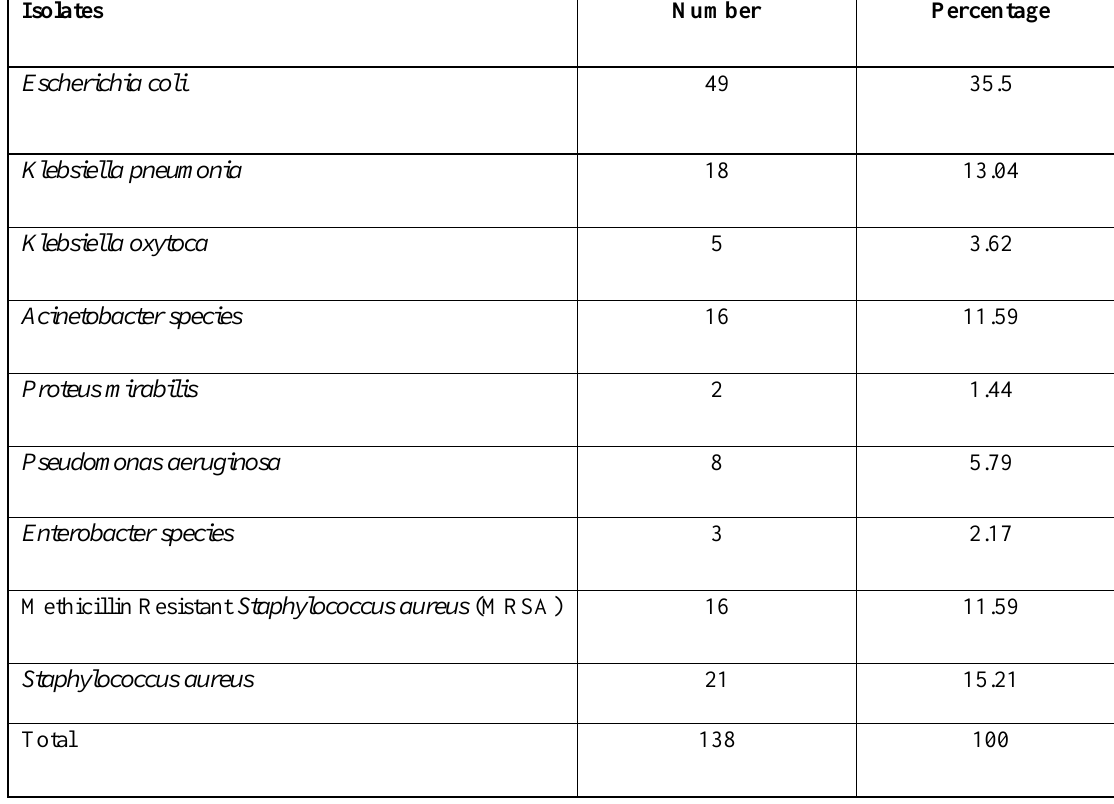
Table 1. Frequency of isolates in pus